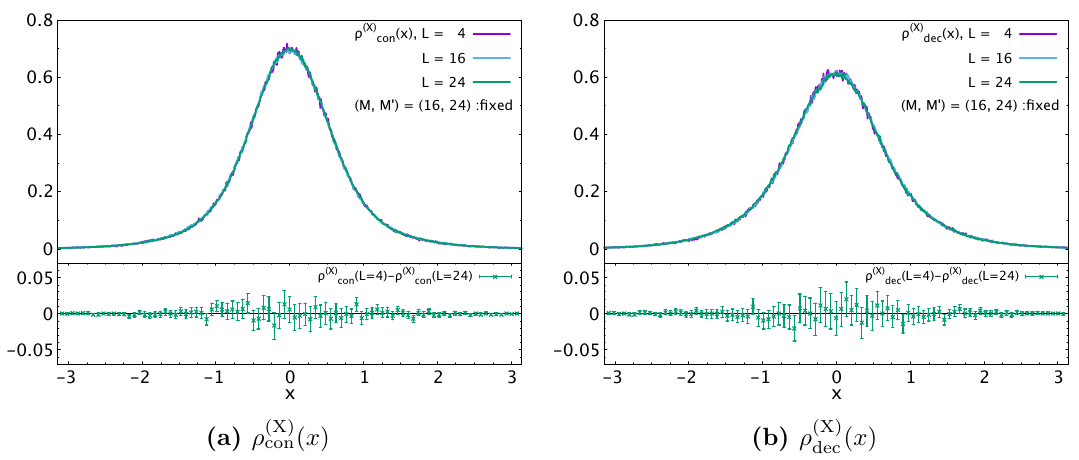
Figure 6. ρ (X) con ( x ) and ρ (X) ( x ) obtained from the Gaussian Matrix model, d = 2 , N = 32 , number dec of lattice sites L = 4 , 16 , 24 , at T = T c = 1 . The finite lattice size effect is small. log2